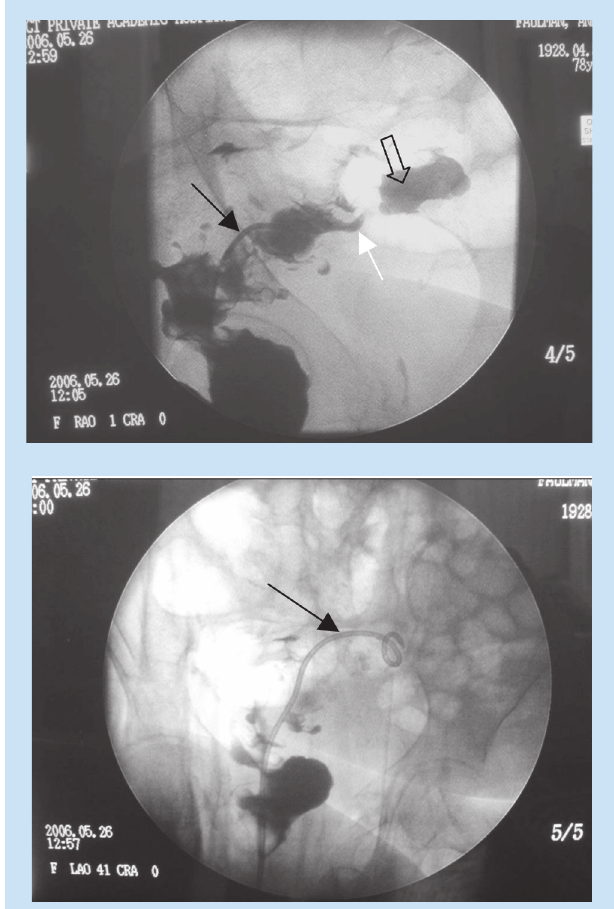
Fig. 2 a and b. Fluoroscopic image (a) during catheter (black arrow) manipulation showing pelvic sidewall collection (open arrow) apparently arising from diverticulum (white arrow) and (b) after placement of the drainage catheter